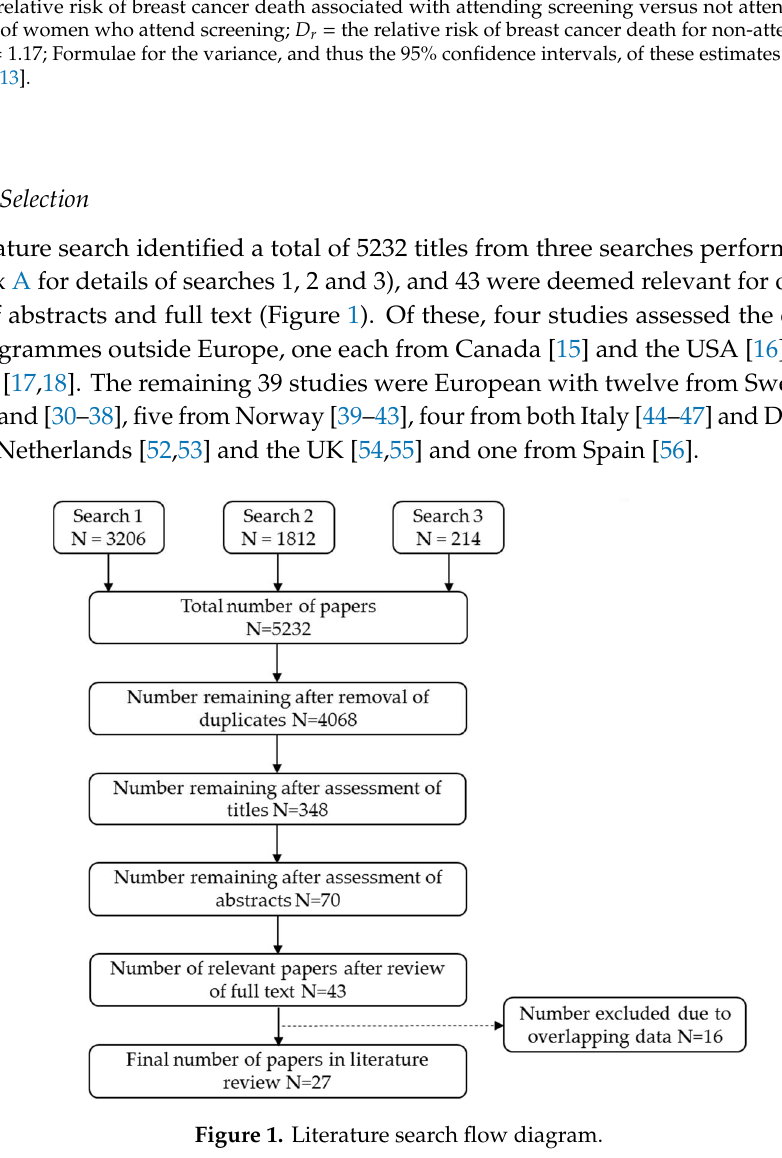
Table 1. Statistical adjustments to estimate effect of invitation and attendance to screening. RR 1 : E ff ect of Invitation to Screening RR 2 : E ff ect of Attendance Adjusted for Self-Selection 𝑝𝑅𝑅 (cid:3002) 𝐷 (cid:3045) 𝑅𝑅 (cid:2869) = 𝐷 (cid:3045) (𝑝𝑅𝑅 (cid:3002) + 1 − 𝑝) 𝑅𝑅 (cid:2870) = 1 − (1 − 𝑝)𝐷 (cid:3045) 𝑅𝑅 (cid:3002) = the relative risk of breast cancer death associated with attending screening versus not attending; 𝑝 = the proportion of women who attend screening; 𝐷 (cid:3045) = the relative risk of breast cancer death for non-attenders versus uninvited = 1.17; Formulae for the variance, and thus the 95%